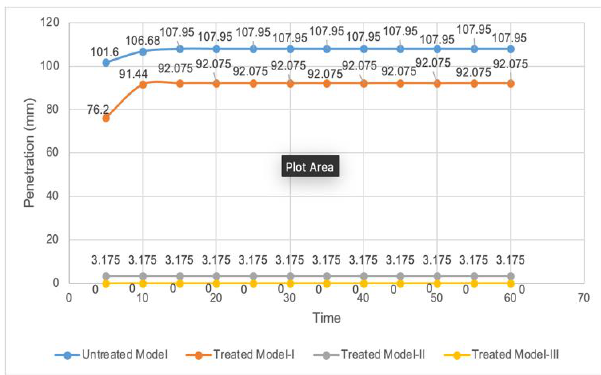
Fig. 16. Penetration vs time curves for untreated and treated